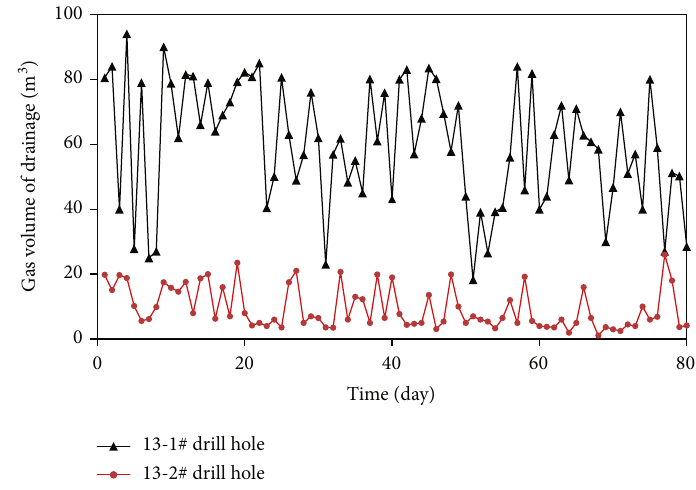
Figure 18: Gas extraction in the borehole group